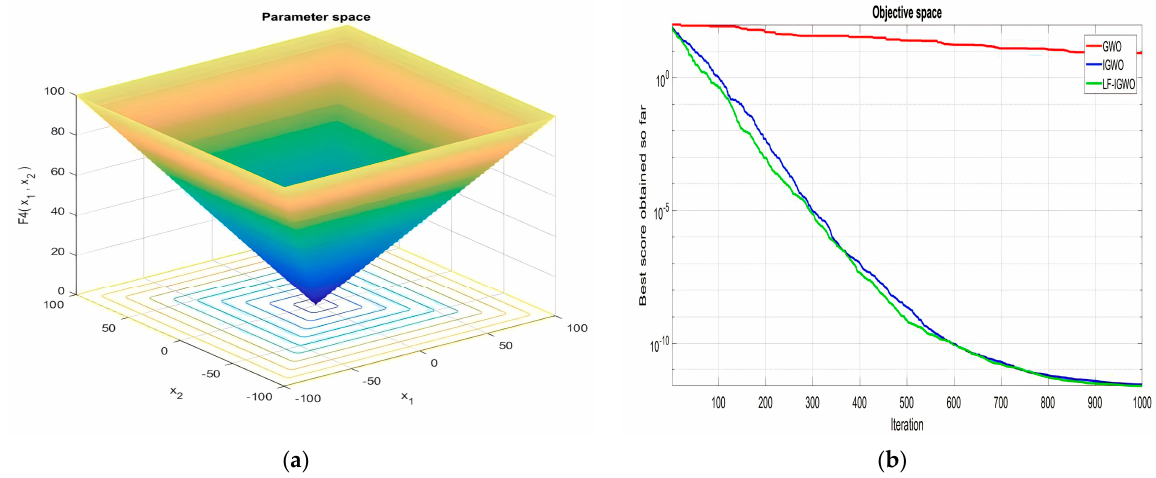
Figure 6. ( a ) Search space for unimodel function F04 ( b ) Comparison of convergence curve for F04.